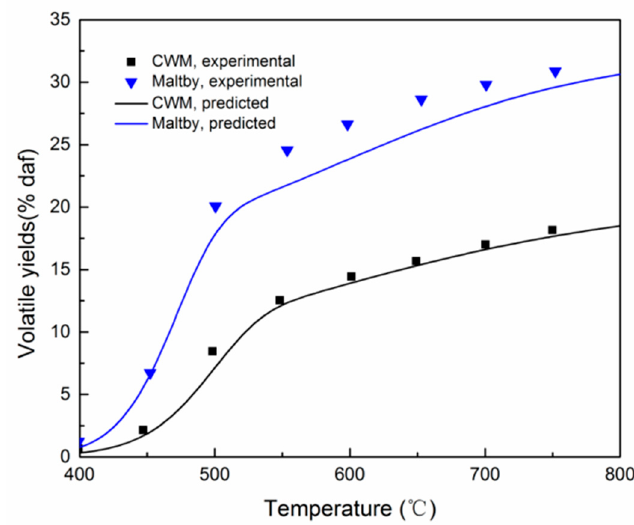
Figure 1. Comparison of prediction and experimental data (Reproduced from [41], Elsevier: 1983) of volatile yields of coal water mixture (CWM) and Maltby coals.